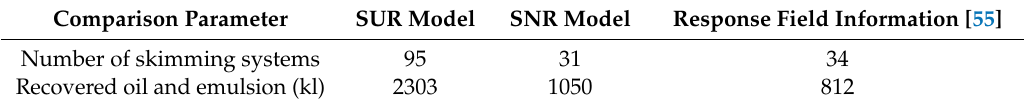
Table 3. Comparison of recovered emulsion and number of skimming systems (for 900 kl spill case).